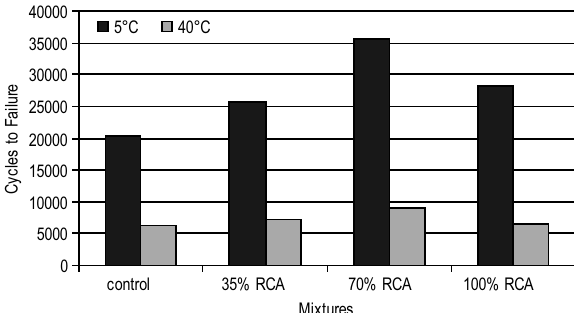
Fig. 2. Number of cycles required for failure vs. mixtures with different RCA contents for gradation type A